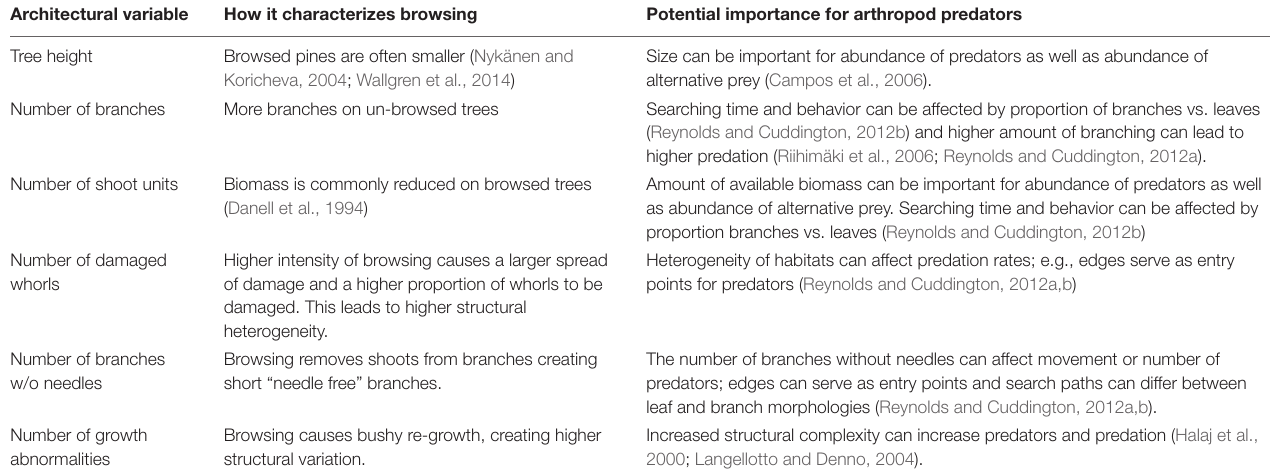
TABLE 1 | Architectural variables measured on the experimental